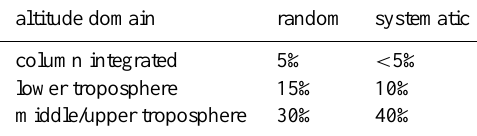
Table 1. Estimated FTIR δ D errors due to a 1% inconsistency be- tween the H 2 O and HDO line parameters (random and